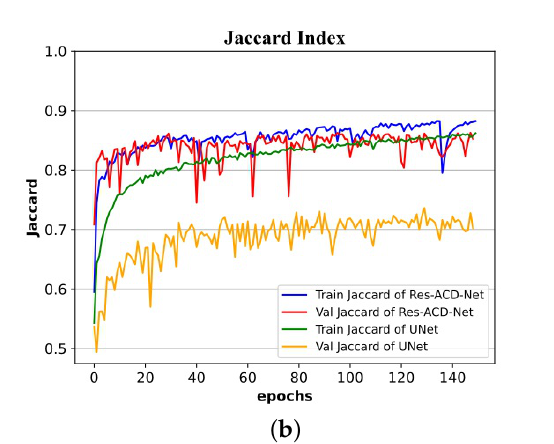
Figure 11. Training and validation processes on the ISIC-2016 dataset: ( a ) curves of Dice coefficient; ( b ) curves of Jaccard index.